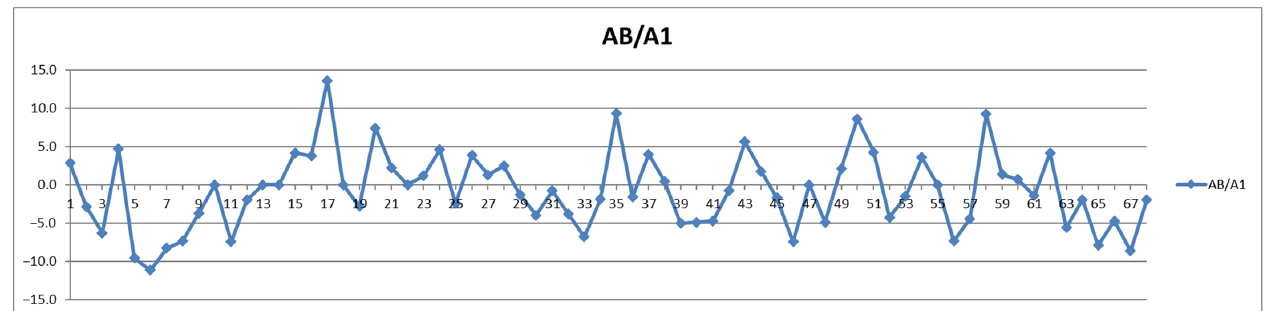
Figure 18. The food intake effect on total apolipoproteins B100 (TPAB) as difference between post- prandial and fasting concentrations as percentage relative to fasting concentration.